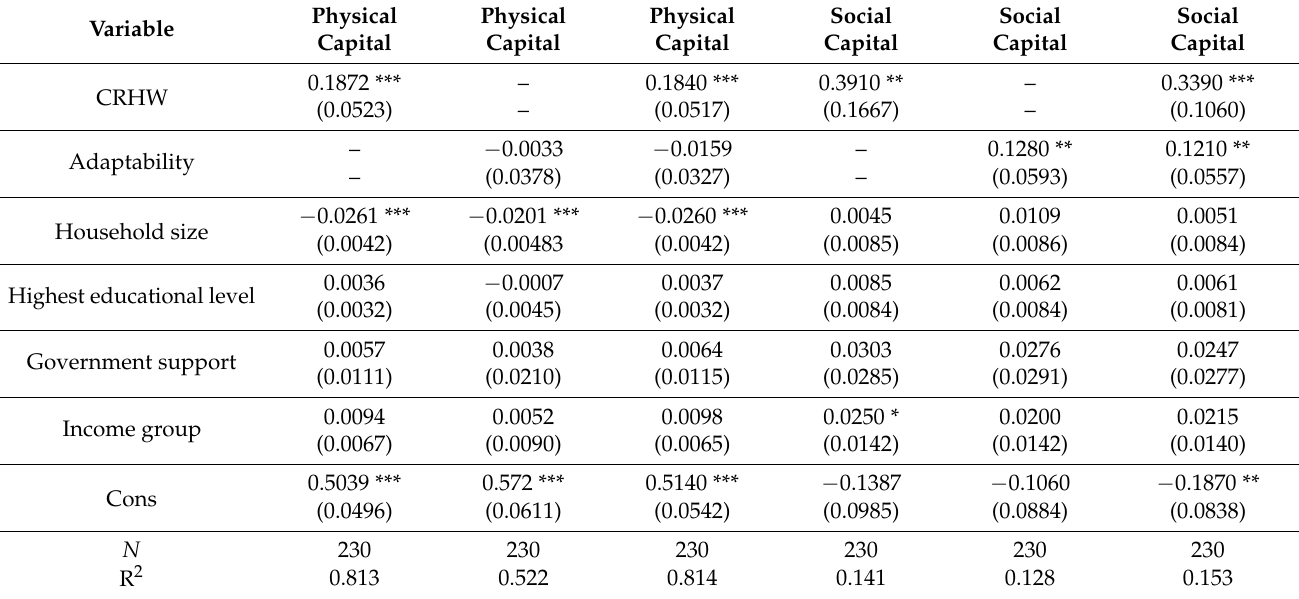
Table 5. Mediation analysis of adaptability between the CRHW and physical and social capital.